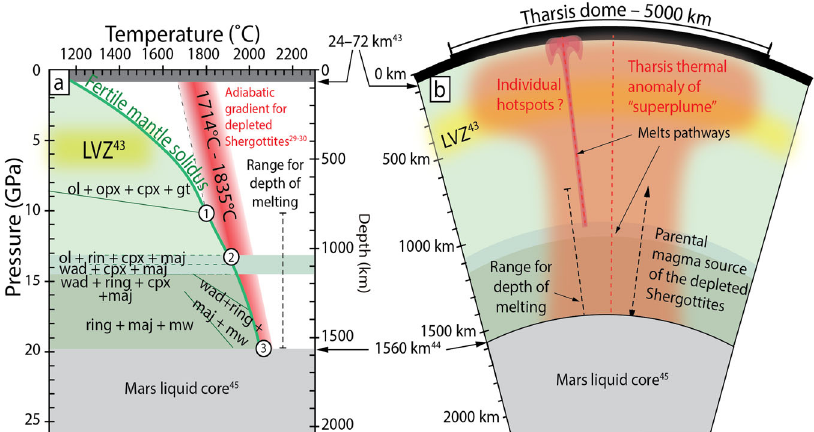
Fig. 4 Melting environment for the formation of the depleted shergottites. a Pressure-temperature-depth phase diagram for the Martian mantle 28 . The adiabatic range for the depleted shergottites (in red) extrapolated using mantle potential temperature 28,29,32 , suggests that melting potentially occurs below 10 GPa (1), within the transition zone (2) and possibly down to the core-mantle boundary (3), i.e. between ~800 and ~1600 km. b Schematic cross- section of Mars below the Tharsis dome, showing the Tharsis superplume beneath the crust as well as the depth range of melting for the parental magmas of the depleted shergottites and potential melts pathways (red dashed lines). Structure of the Martian interior and layers thicknesses are inferred from SEIS (Seismic Experiment for Interior Structure) data on board of the InSight lander 80 – 82 . ol olivine, opx orthopyroxene, cpx clinopyroxene, gt garnet,